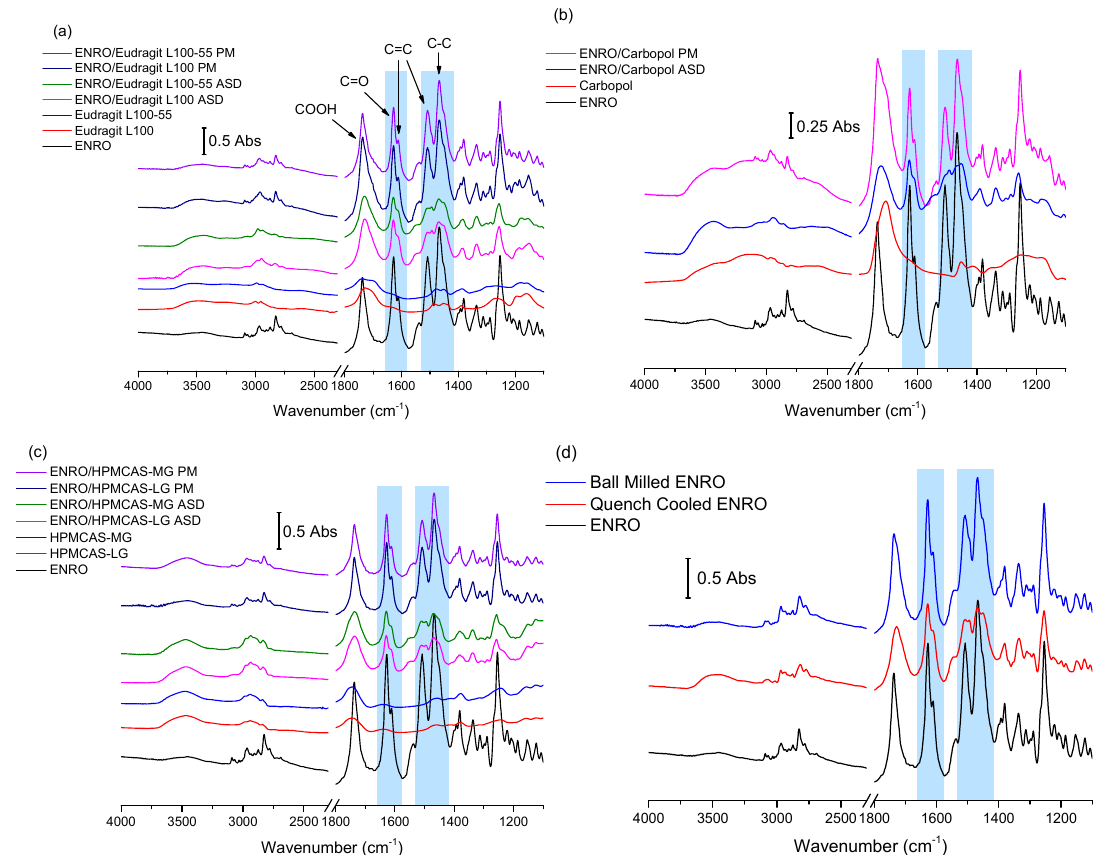
Figure 3. FTIR spectra of ASDs and physical mixtures (PM) containing ( a ) Eudragit L100 and Eudragit L100-55 40% ( w / w ) ( b ) Carbopol 40% ( w / w ), ( c ) hydroxypropyl methylcellulose acetate succinate grades LG and MG (HPMCAS-LG and HPMCAS-MG) 60% ( w / w ), and ( d ) ball milled and quench cooled ENRO. The areas of the spectra that undergo significant changes upon amorphization are highlighted in violet.